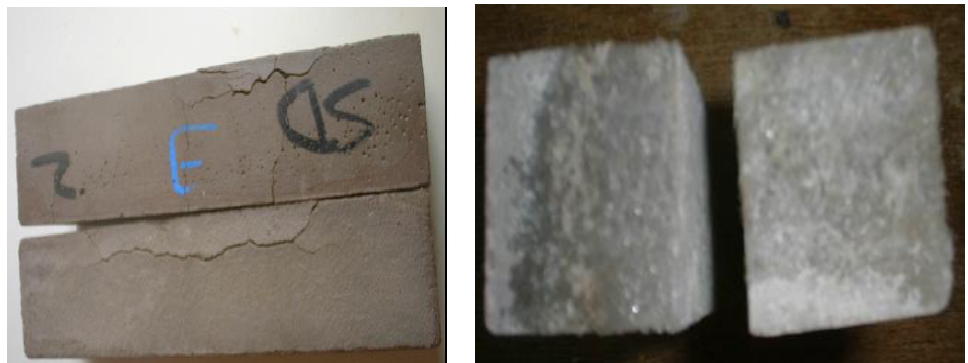
Figure 12. Beam of dune sand mortars immersed in sodium sulfate solution (5%) at 180 days [73].